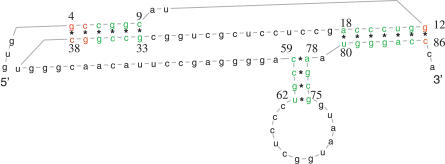
RNA Structure with Pseudoknot Predicted by SimulFold for the HDV Sequence of Organism AJ309880 Using the MCMC Results Generated with Parallel TemperingThe pairing probabilities estimated by SimulFold are colour-coded and range from bright green (high probability) to bright red (low probability). The pairing probabilities for this structure range from 0.62 for the pair at sequence positions {4, 38} to one for most of the base-pairs, e.g., the one at sequence positions {6, 36}. For this figure, we have adopted a nonlinear colouring scheme; otherwise, all base-pairs would simply come in slightly different shades of green.